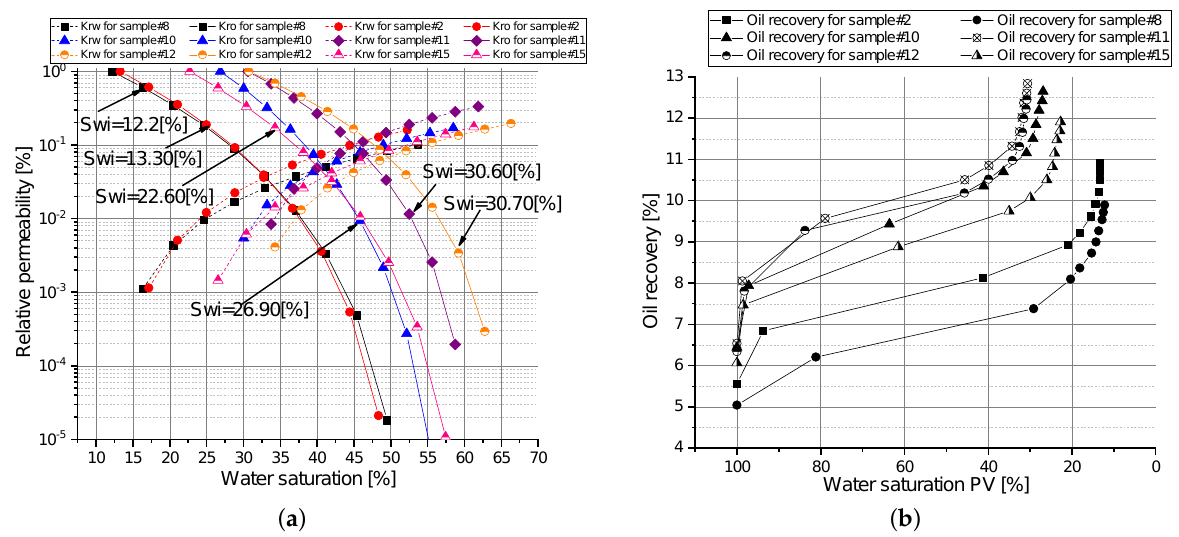
Figure 10. ( a ) Relative permeability versus water saturation indicating the impact of irreducible water saturation Swi wettability on the relative permeability and ( b ) oil recovery versus water saturation highlighting how wettability affect the relative permeability.